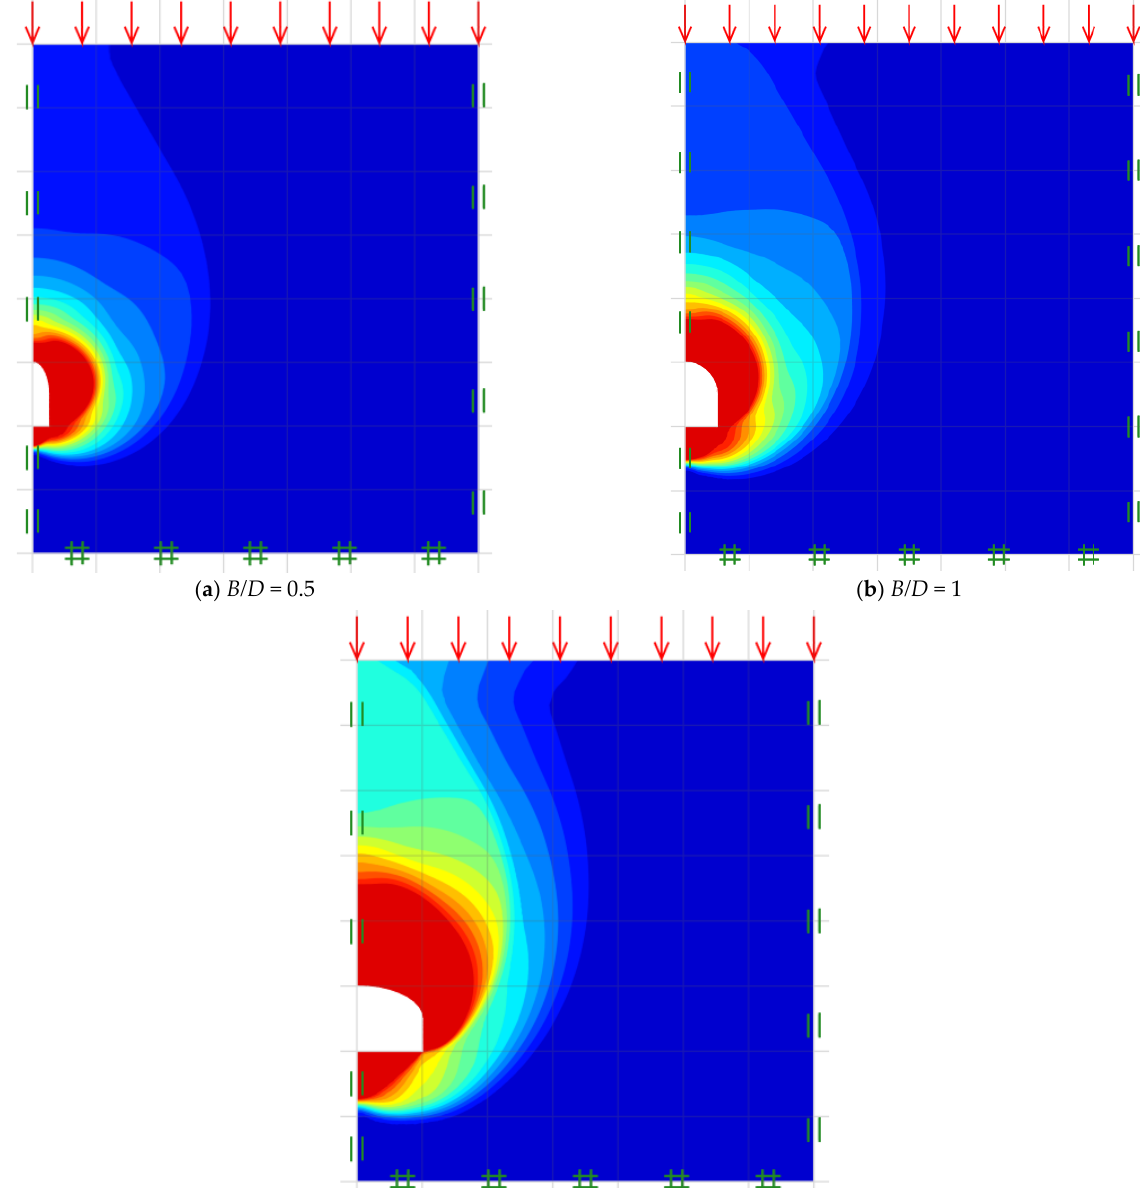
Figure 8. Shear dissipations for various B/D ( C/D = 5, γ D/c' = 0 and ϕ = 25°).